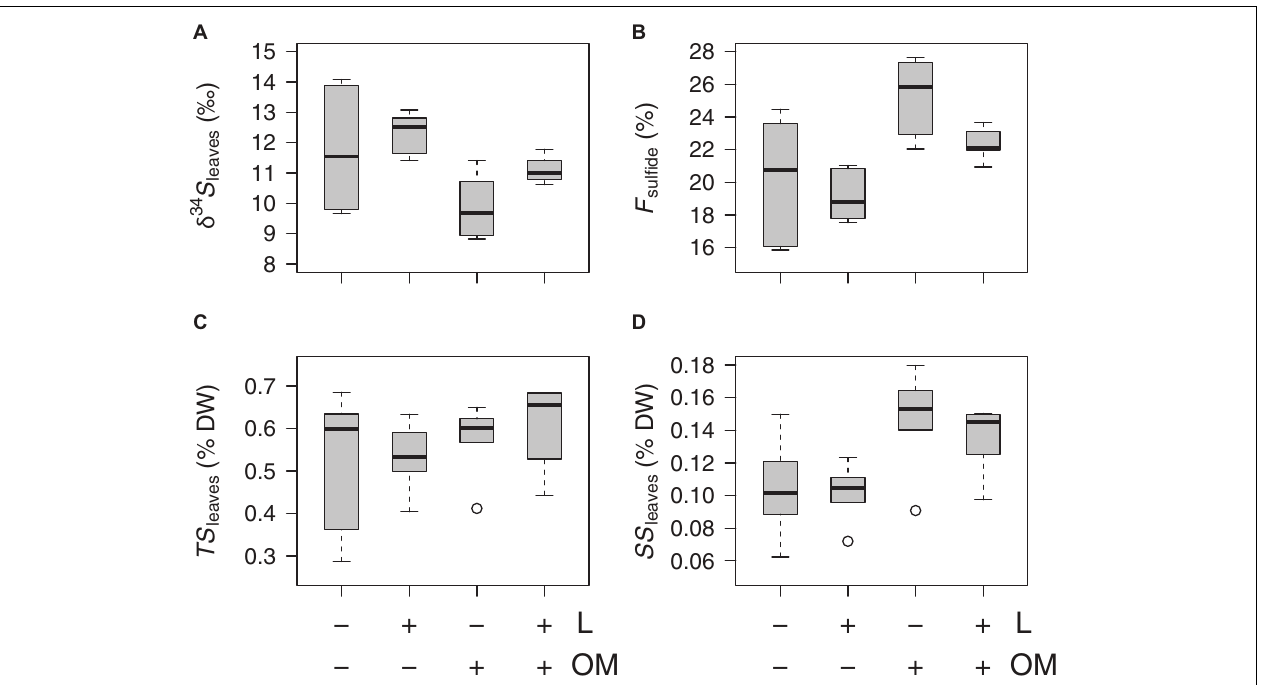
FIGURE 3 | Boxplots of Z. noltei (A) sulfur isotopic signatures of leaf tissue ( δ 34 S leaves ), (B) sedimentary sulfide intrusion ( F sulfide ) in leaf tissue, (C) leaf tissue contents of total sulfur ( TS leaves ), and of (D) sulfur derived from sedimentary sulfides ( SS leaves ) per treatment (n = 6 per treatment) after 50 days. L, addition of Loripes orbiculatus clams; OM, addition of organic matter; DW, dry weight. Midline in box; median; box: 25th and 75th percentiles; whiskers: 1.5 × interquartile range; circles: outliers.